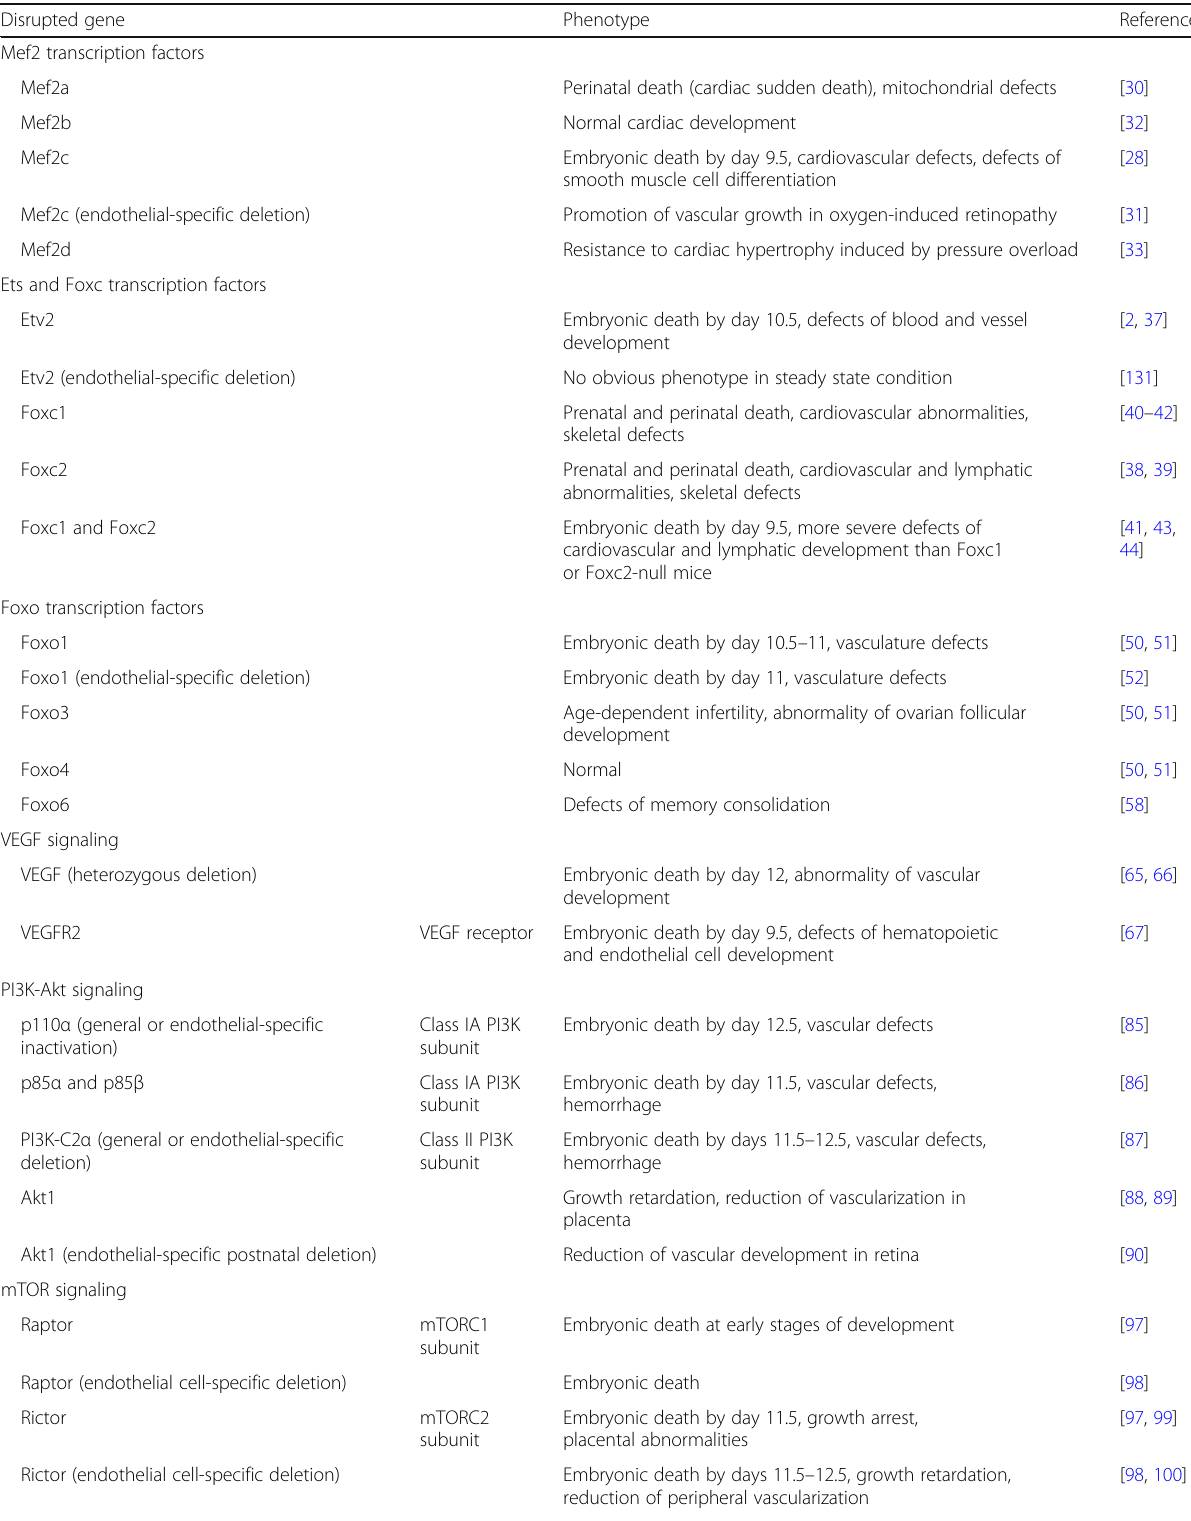
Table 1 Mouse phenotypes Disrupted